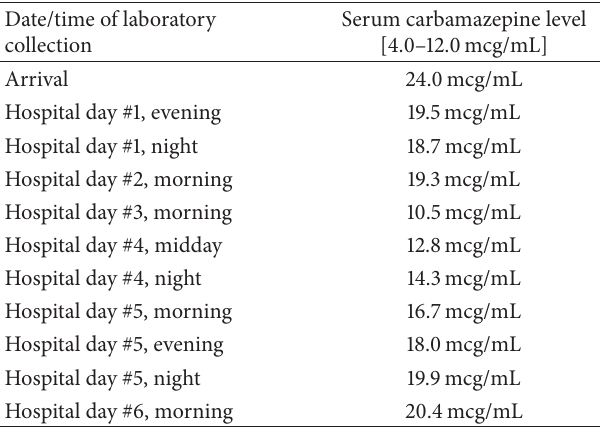
Table 1: Serial serum carbamazepine levels drawn during hospital